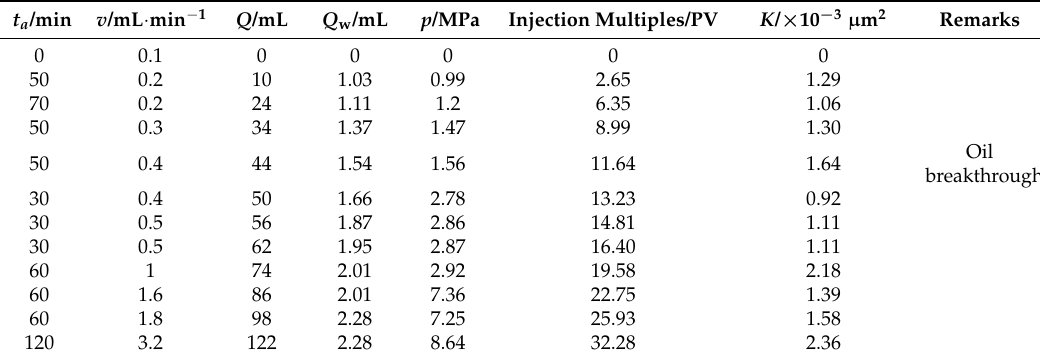
Table 13. Third oil saturation experiment results of